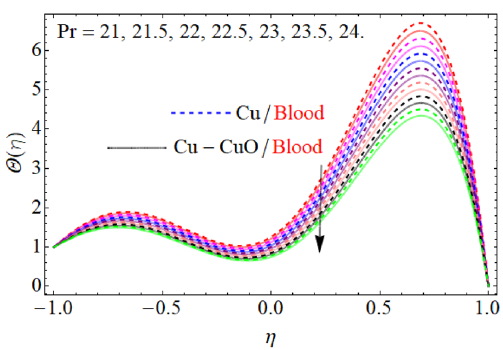
Figure 5. Pr influence on θ(η) .